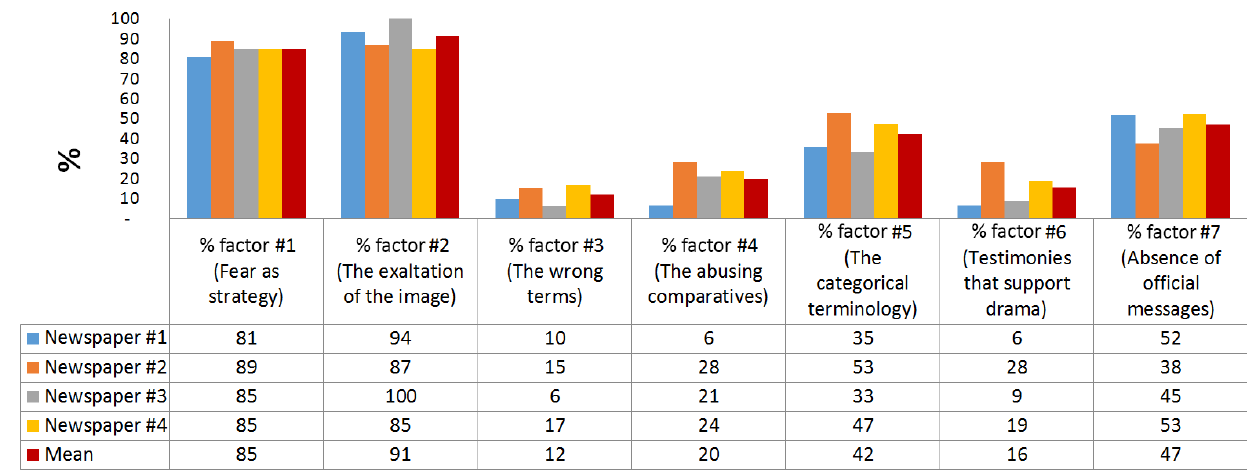
Figure 2. Proportion of “meteo-show” factors appearance in selected newspaper during studied